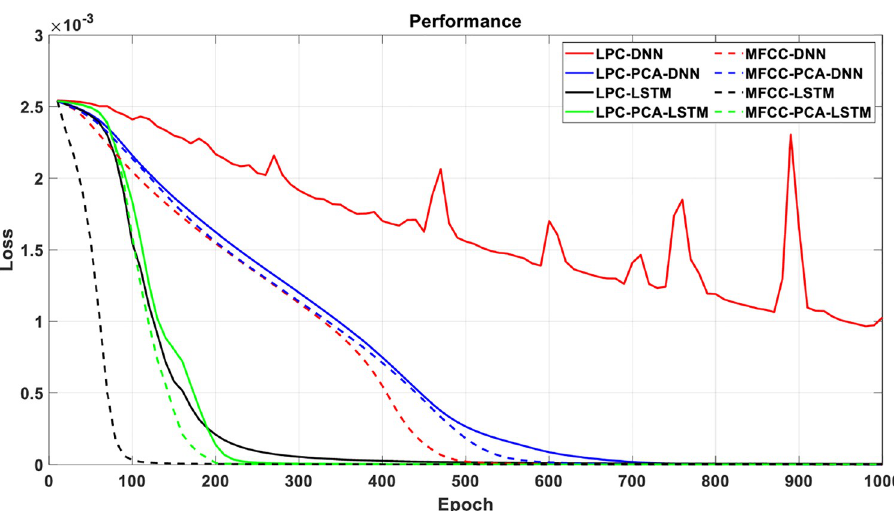
Fig 39. The loss function of network structures, LPC-DNN, LPC-PCA-DNN, LPC-LSTM, LPC-PCA-LSTM, MFCC-DNN, MFCC-PCA-DNN, MFCC-LSTM and MFCC-PCA-LSTM, as the epoch increases. 20-layer structure is selected in DNN while 1200-hidden neurons with 2 layers is set in LSTM. It seems that MFCC-LSTM model needs only 100 epochs to let the loss function converge completely, which can also save the training period.